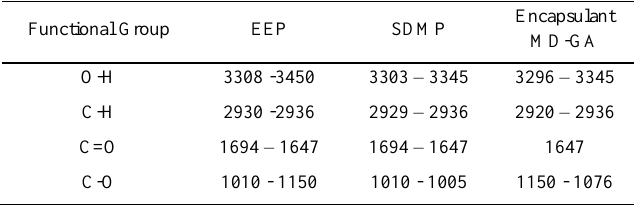
Table 3. FTIR Spectra Result